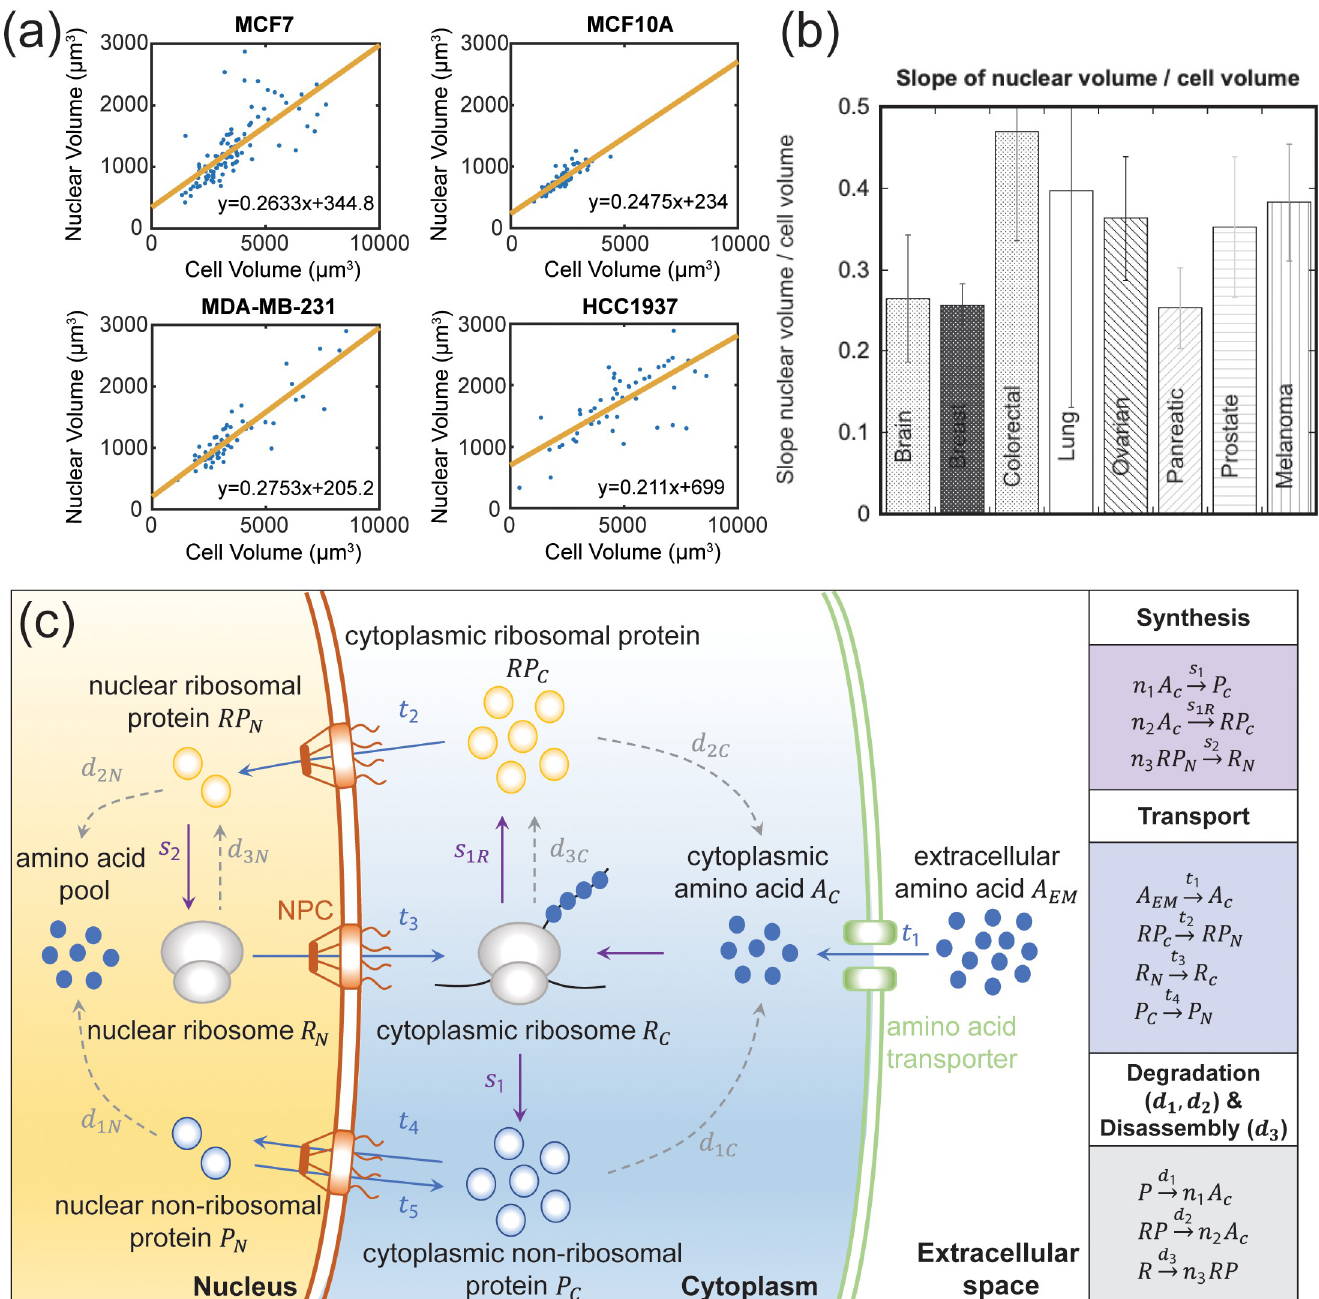
Fig 1. (a) Nuclear volume vs. cell volume for several cell lines grown on 500Pa polyacrylamide (PAA) substrates coated with collagen I. Each point is a single cell. The nuclear volume is proportional to the cell volume. (b) Slope of nuclear volume vs. cell volume for cell lines from several different types of human tissue. Brain (T98G, U-87), breast (MCF10A0JSB, HTERT-HME1, MDA-MB-231, MCF7, HCC1937a, T-47D), colorectal (SW480, SW620, HT-29, HCT116), lung (NCI-H2087, NL20, NCI-H2126), ovary (SK-OV-3, NIH: OVCAR-3, Coav3), pancreas (Panc-1, HTERT-HPNE, Capan-1), prostate (DU145, 22RV1, LnCaP Clone FG, PC-3, RWPE-1), skin (WM266–4, A375, MeWo, SK-MEL-2). (c) A model of eukaryotic cell growth with mass transport. During cell growth, amino acids are imported into the cytoplasm and assembled into non-ribosomal proteins and ribosomal proteins by mature ribosome particles. The ribosomal proteins are transported into the nucleoplasm to combine with ribosomal RNA to mature into ribosome particles, which are then transported back out to the cytoplasm. Non-ribosomal proteins are also actively transported in and out of the nucleoplasm. Proteins and ribosomes are also actively degraded. These processes can be captured by a simple set of mass flux